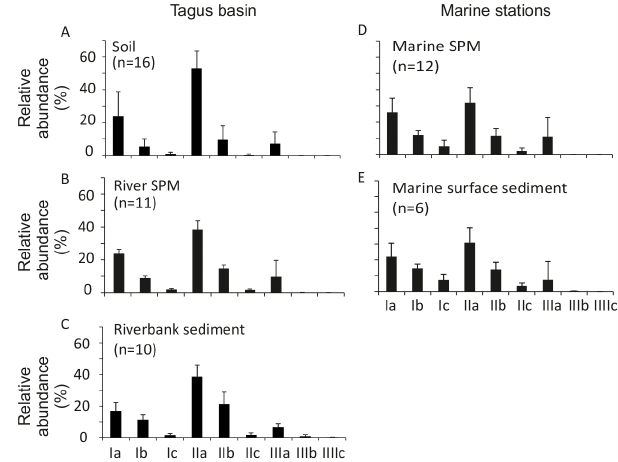
Figure 4. Average CL brGDGT distribution of (a) Tagus soils, (b) Tagus River SPM, (c) riverbank sediments, (d) marine SPM, and (e) marine surface